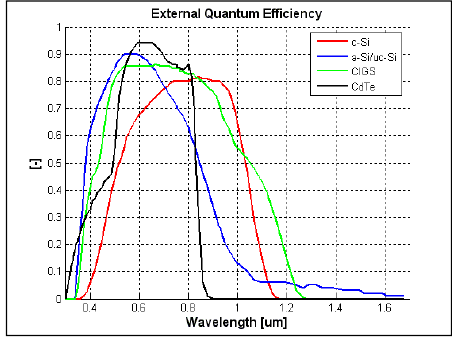
Figure 1. External quantum efficiency of four module technologies.